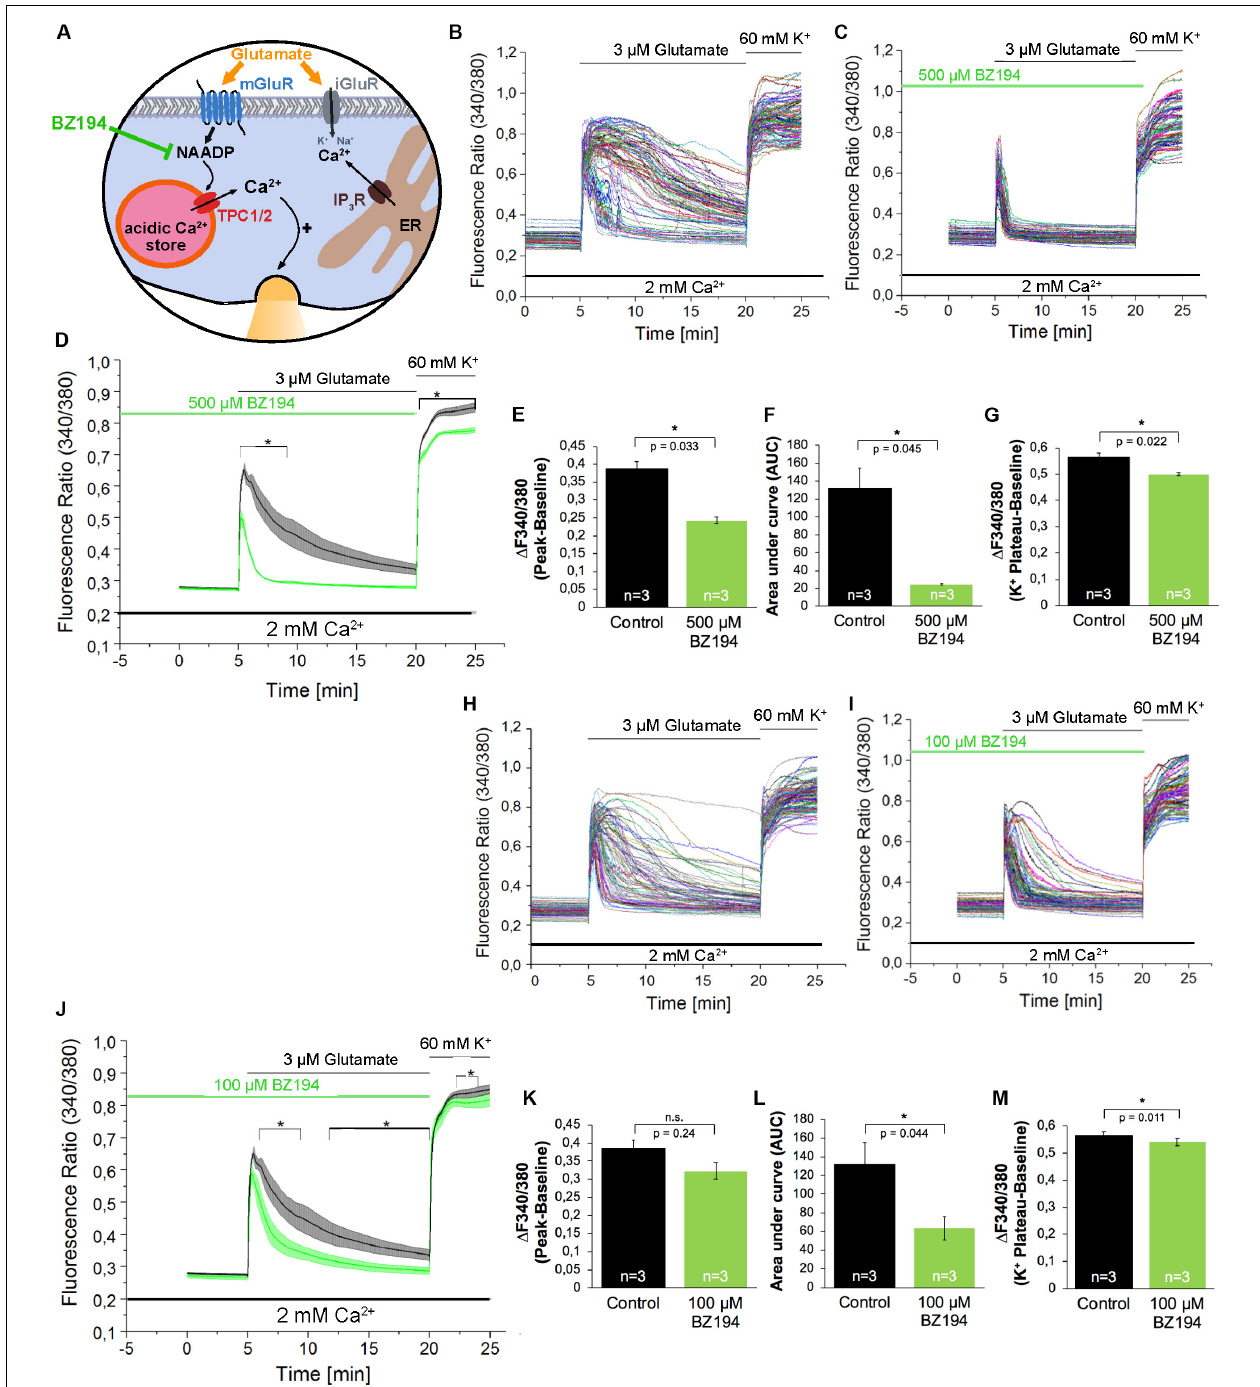
FIGURE 3 | The effect of the NAADP antagonist BZ194 on the time course of the glutamate-induced Ca 2 + increase in hippocampal neurons. (A) BZ194 acts as a NAADP antagonist (Dammermann et al., 2009). (B,C,H,I) Representative traces of the glutamate-induced changes in the F340/380 fluorescence intensity values of hippocampal neurons without (B,H) and with 500 µ M (C) or 100 µ M (I) pre-incubation with BZ194. (D,J) Average traces are given as the arithmetic mean ± SEM of the averaged F340/380 fluorescence intensity values without (black, n = 719 cells in D and J ) and with (green) 500 µ M ( D , n = 650 cells) or 100 µ M ( J , n = 611 cells) BZ194 pre-incubation. Data from independent C57Bl/6N preparations ( n = 4) are shown. During all experiments, the cells were remained in physiological solution containing 2 mM Ca 2 + . For measurements with BZ194, the cells were pre-incubated for 5 min. After 5 min recording, the cells were stimulated with glutamate (3 µ M) for 15 min. For the last 5 min, the cells were stimulated with high potassium solution (60 mM K + ). Finally, the amplitude of the glutamate-induced calcium increase (E,K) as well as the AUC (F,L) and the amplitude of the high-potassium induced calcium transients (G,M) were analyzed. **: p < 0,01; *: p < 0,05.